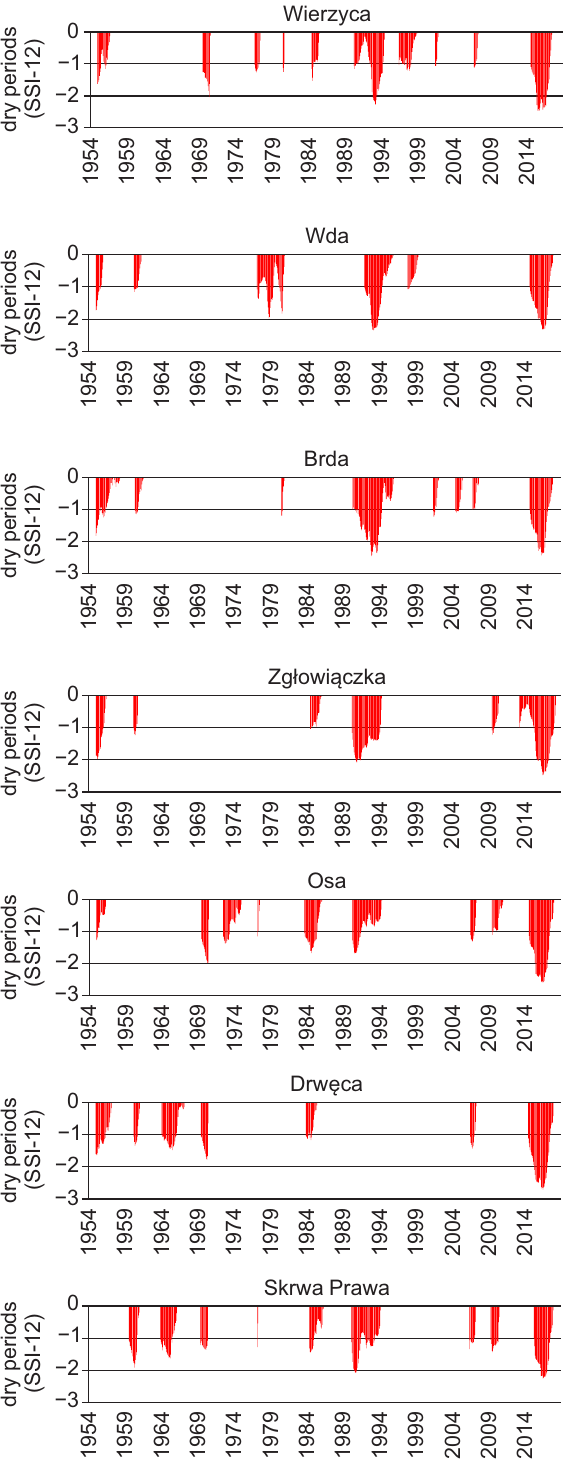
Fig. 5. The course of dry periods (SSI-12) on analysed rivers in 1954–2018. SSI, Standardised Streamflow